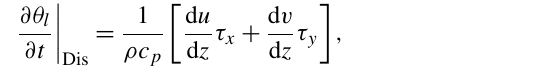
Table 7. Summary of naming conventions used in describing RCS-IND1 simulation experiments for Titli and Fani cases. Simulations for which frictional heating is activated in the Unified Model configuration are signified by “_FH” after the relevant run identifier. ATMfix uses fixed SST for the duration of a simulation, while ATM has daily updating